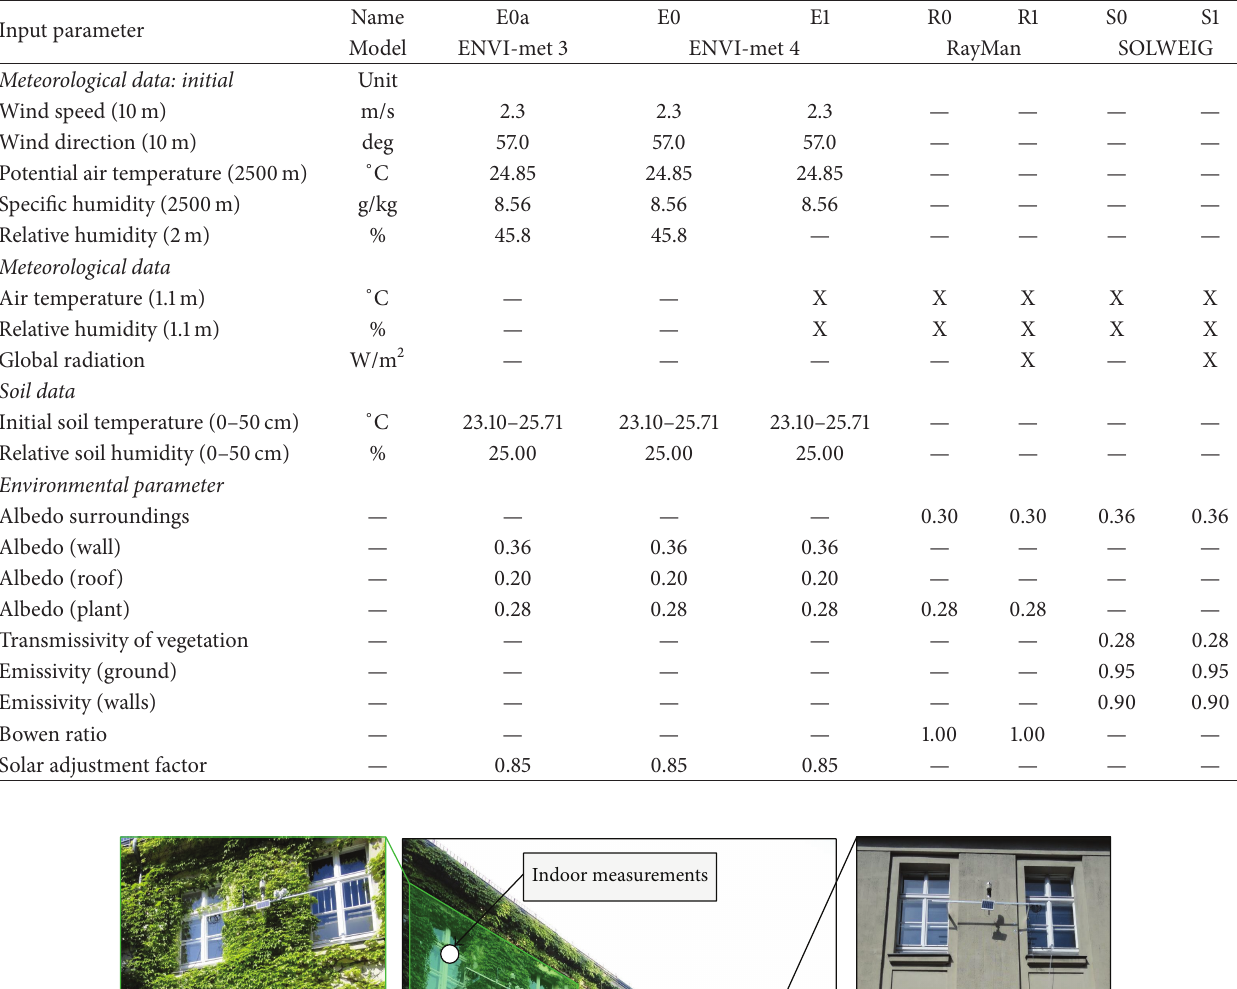
Table 2: Overview of the input parameters and model settings in the seven experiments. “X” represents input of times series of meteorological data.